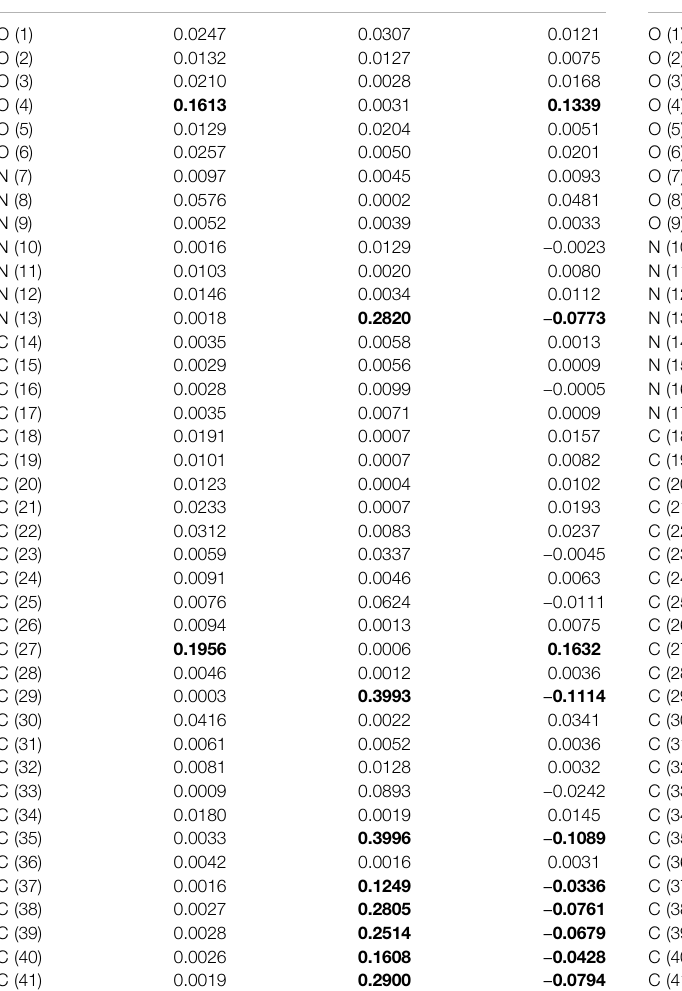
TABLE 12 | Comparison of several reactivity descriptors: condensed electrophilicity ω k , condensed nucleophilicity N k and condensed